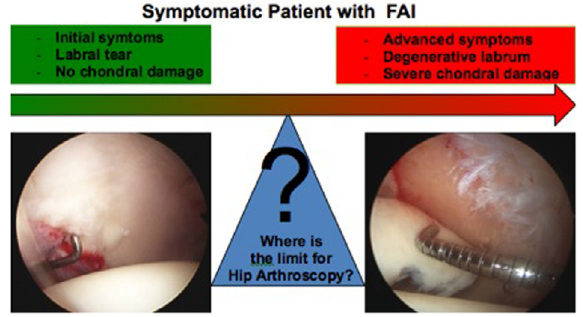
Table 1. In patients with a bone deformity of the hip (PFA, dysplasia) progressive damage of the intra-articular structures (labrum, articular cartilage) occurs. In early stages, labrum and chondrolabral junction injury are present. In more advanced stages, extensive full-thickness chondral damage occurring in the weight- bearing area of the joint can be identified. To establish the limit between these two stages recognizing which patients are going to profit from arthroscopy (stabilization of chondral injury, labral repair, and correction FAI) remains a challenge in clinical practice.